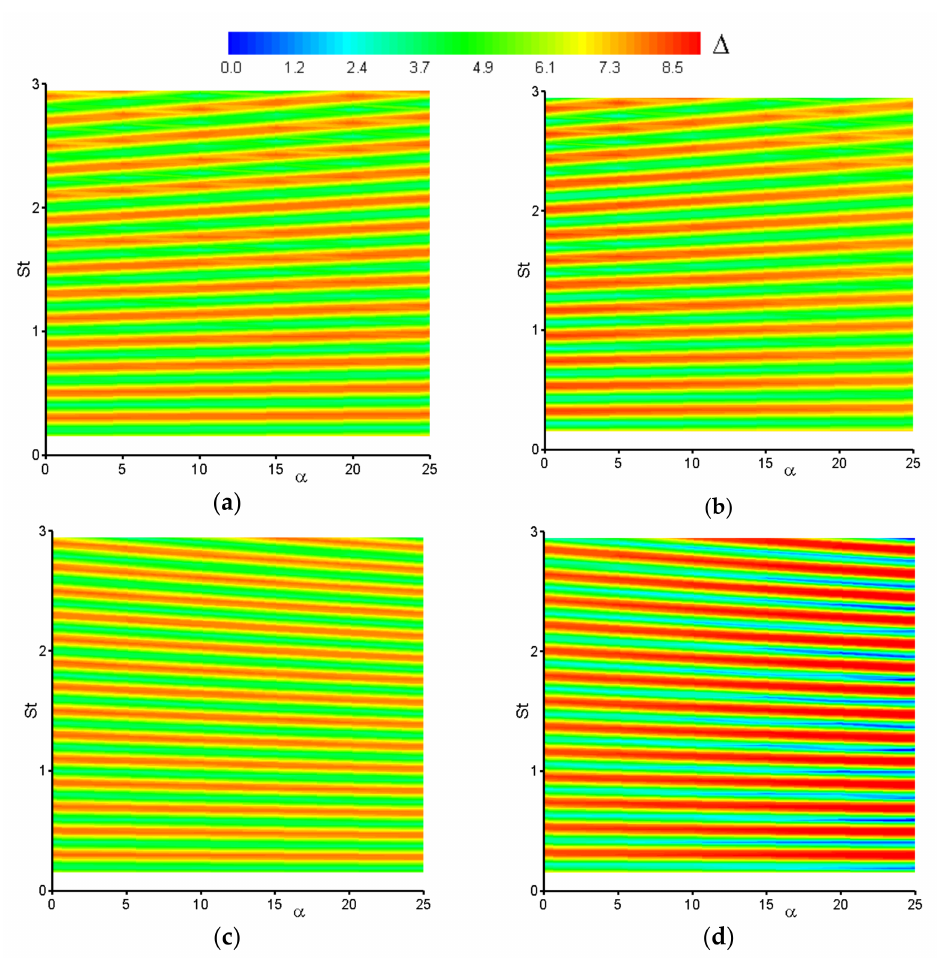
Figure 13. Low to high frequency ( St = [0.294; 2.94]) noise radiation from the trailing edge of an airfoil set at low to high incidences ( α = [0 ◦ ; 25 ◦ ]). Deltas (in dB) between the incident and total RMS pressure fields, as recorded for two pairs of microphones: M1 ± ( x M / c = 0.5) and M2 ± ( x M / c = 2) located on top and bottom walls: M1 + ( a ), M1 − ( c ), M2 + ( b ), M2 − ( d